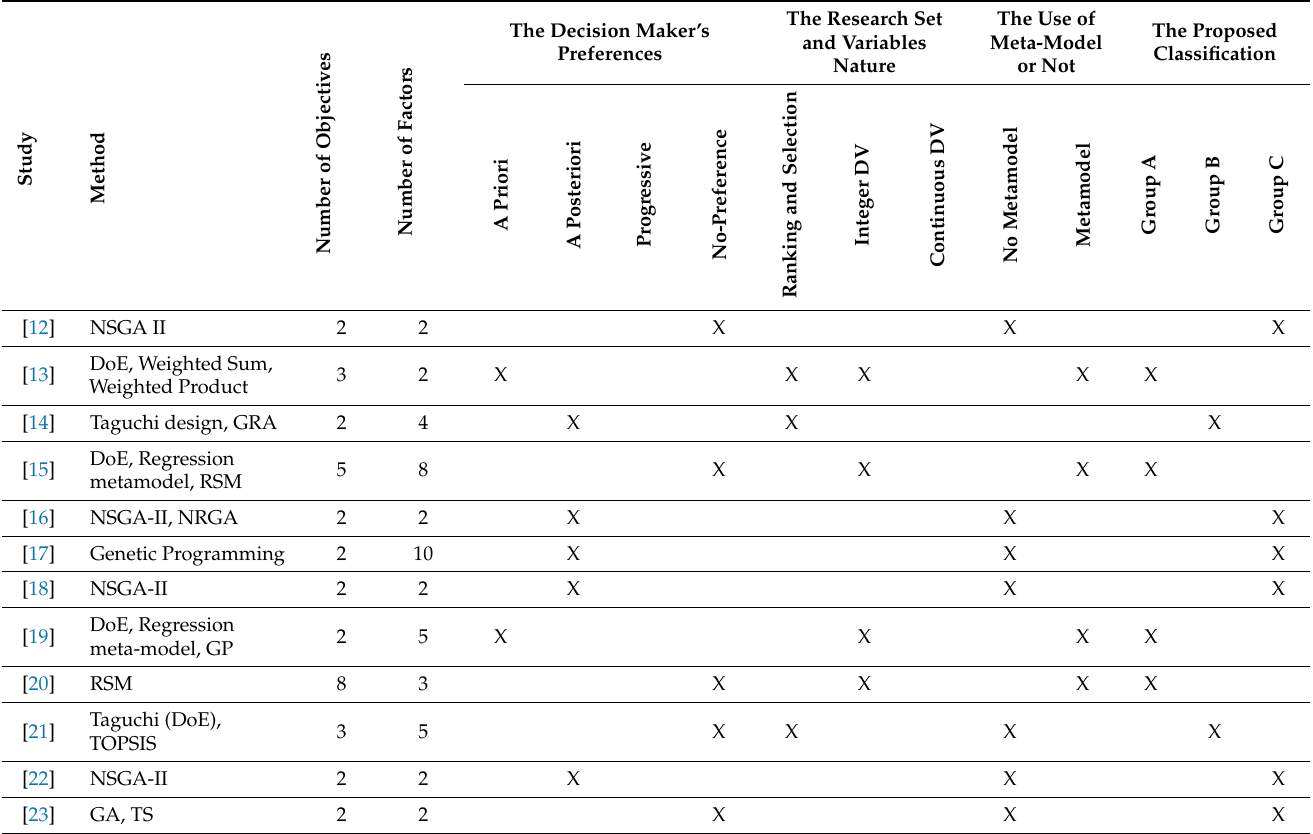
Table 2. MOSO classification for FMS design (since year